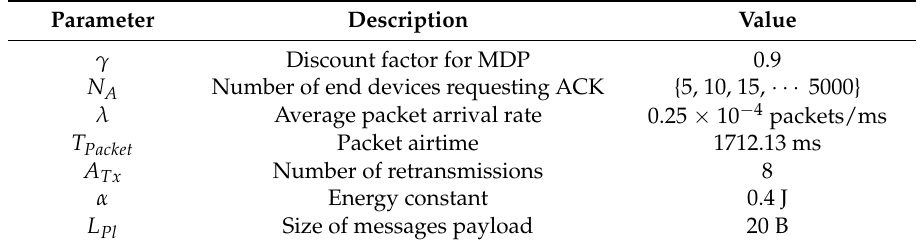
Table 1. Simulation parameters for the evaluation of Packet Delivery Ratio and Energy Cost of Data